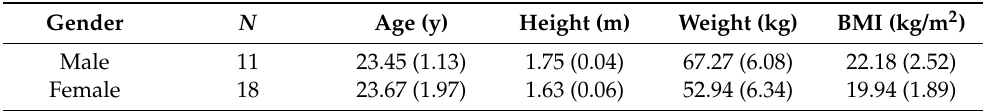
Table 2. Background characteristics for the 29 participants.